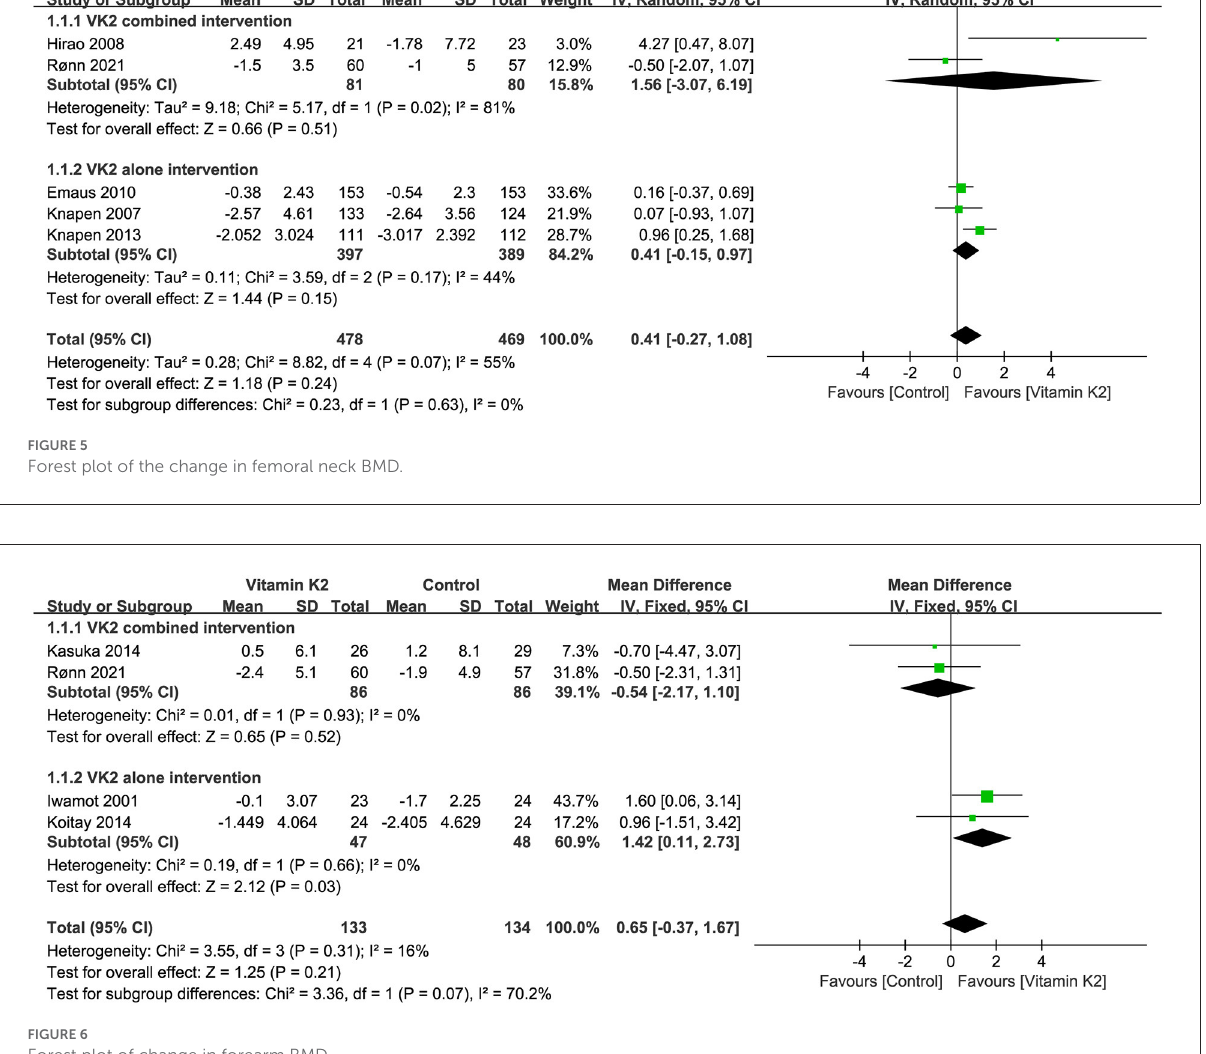
FIGURE6 Forest plot of change in forearm